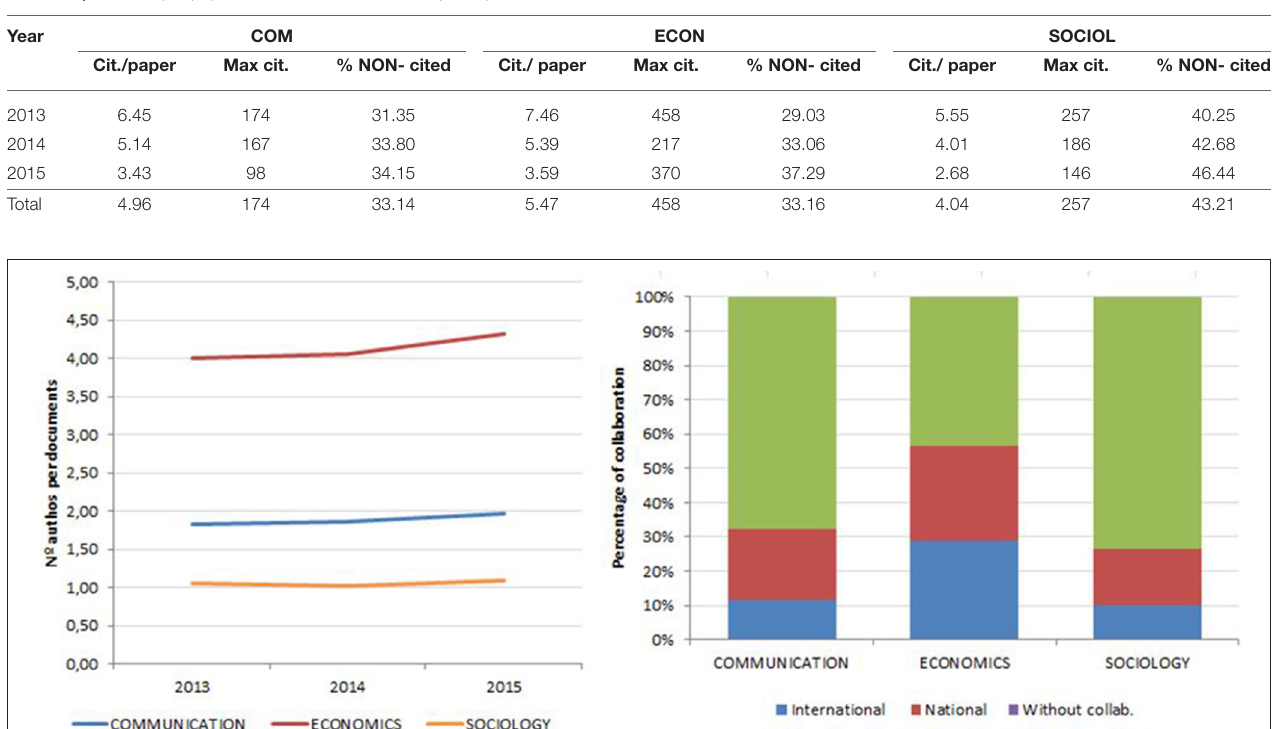
TABLE 3 | Citations per paper, total number of citations by discipline.